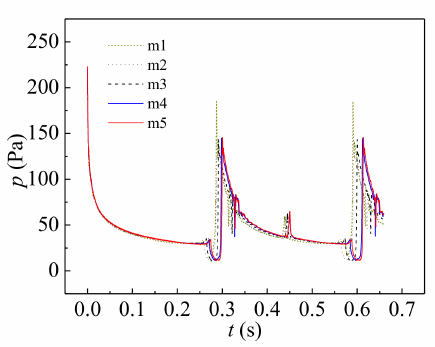
Figure 3. Pressure variation at location z = 5 mm, r = 0 mm calculated using di ff erent meshes.